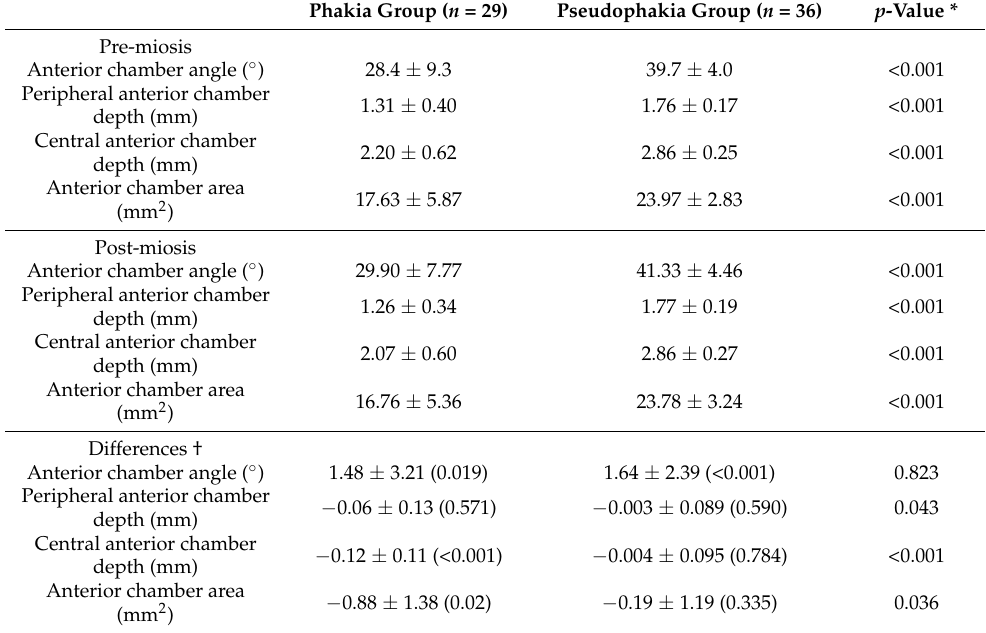
Table 2. Comparisons of anterior chamber parameters between phakia and pseudophakia groups before and after